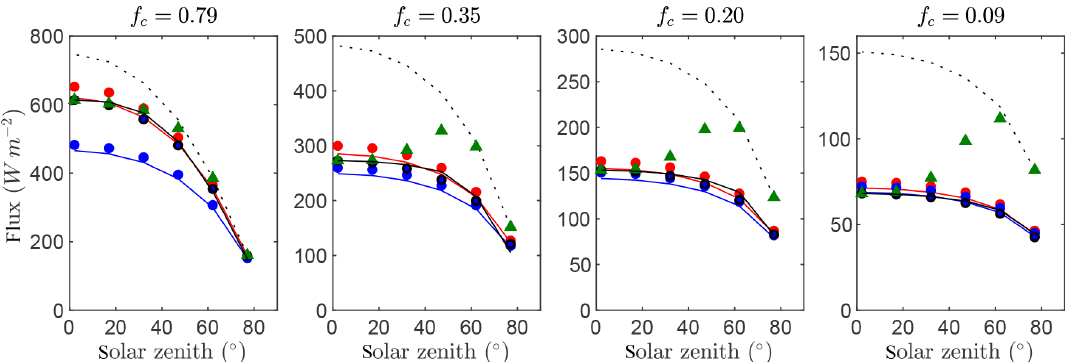
Figure 6. Flux of intercepted radiation versus solar zenith angle for a half-diurnal cycle in a canopy of spherical crowns filled with uniformly distributed leaves (see Fig. 3c). Varying ground cover fractions f c were simulated as labeled in each pane. The exact flux is given by the output of the 3-D model (black line), which is compared against the 1-D models BINOM (red line), NIL99_B (red circle), and NIL99_P (blue circle) and Ni10_P (blue line), OM_CON (black circle), OM_VAR (green triangle), and HOM (dotted